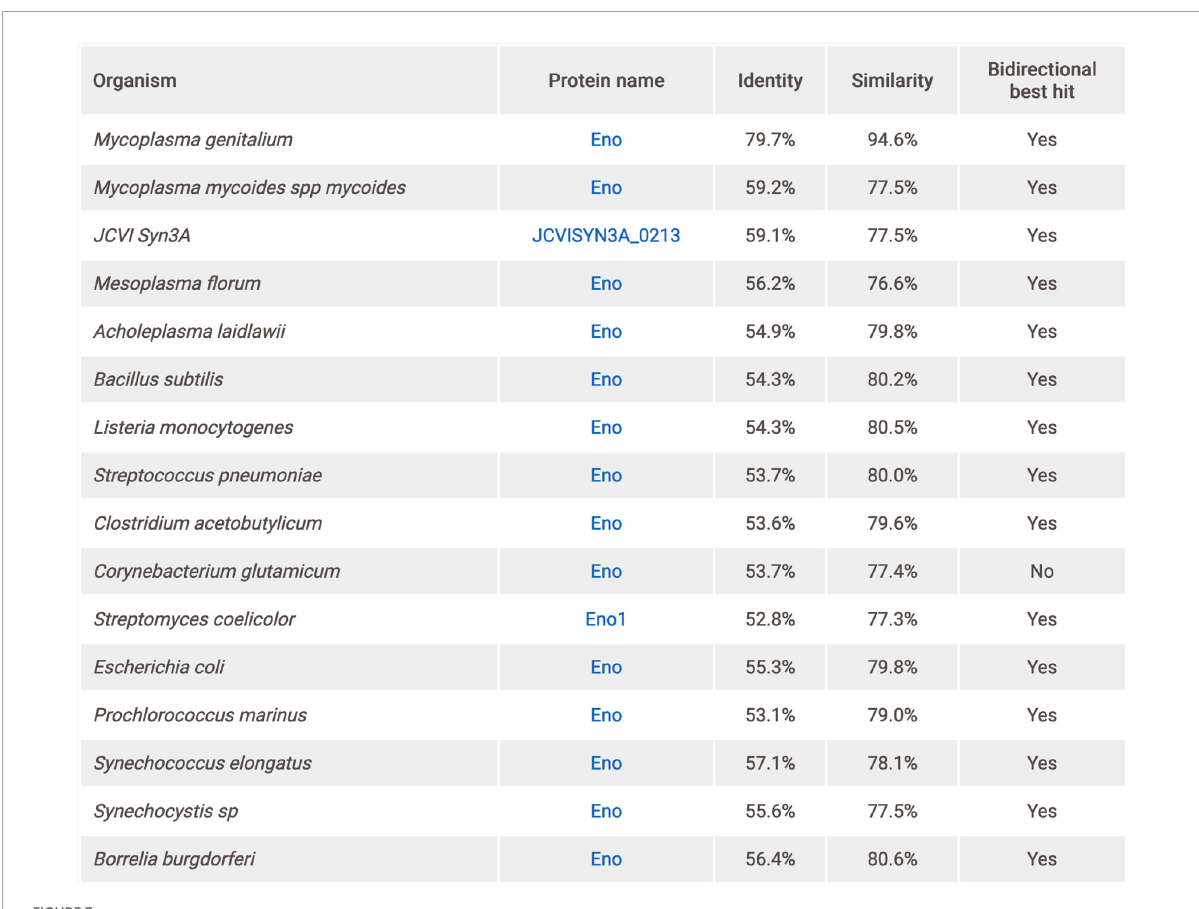
of information on protein-protein interactions comes from a global in vivo study (O’Reilly et al.,